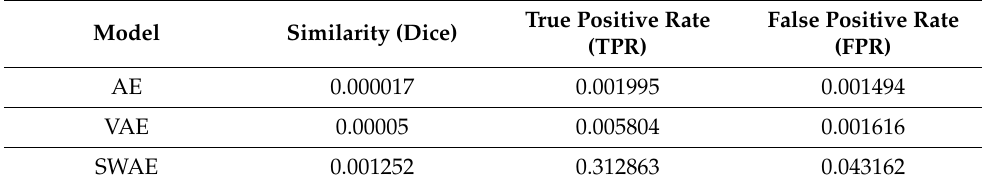
Table 5. Indicators of anomalous region detection results of models.